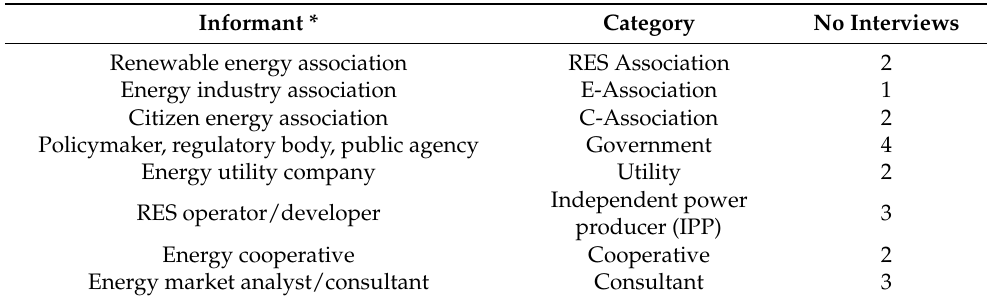
Table 1. Categorisation list of informants interviewed for the study, along with the number of interviews conducted for each category. Informant * Category No Interviews Renewable energy association RES Association 2 Energy industry association E-Association 1 Citizen energy association C-Association 2 Policymaker, regulatory body, public agency Government 4 Energy utility company Utility 2 Independent power 3 RES operator/developer producer (IPP) Cooperative